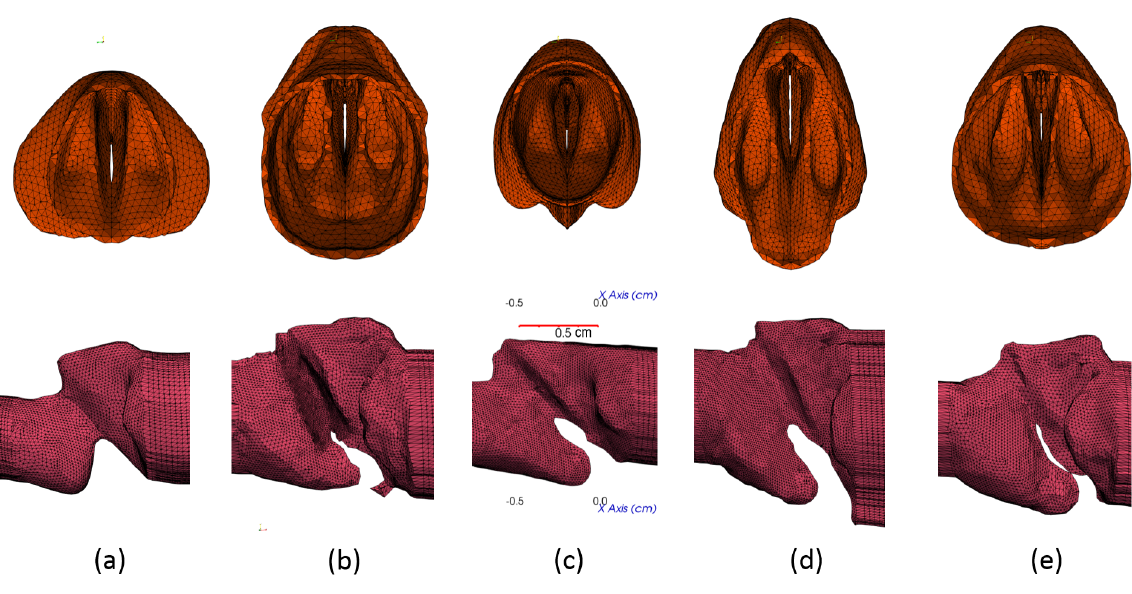
Figure 3. Top row : the reconstructed larynx models for all samples as viewed from the supraglottal side for samples 1 to 5 in ( a – e ) respectively; bottom row : the corresponding extracted lumen. A scale of 0.5 cm is shown in ( c